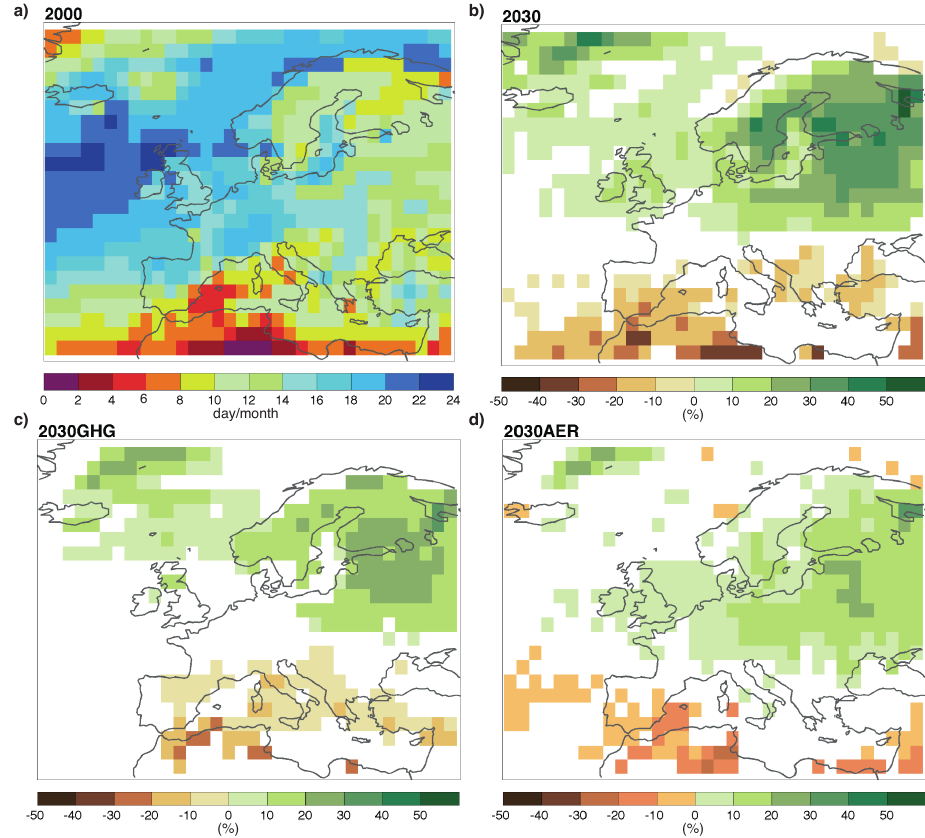
Figure C1. Average number of rainy days per month during winter (DJF) in the 2000 simulation (a) . Percentage changes in the average Fig. C1: Average number of rainy day per month during winter (DJF) in the 2000 simulation (a). 923 number of rainy days per month for 2030 (b) , 2030GHG (c) , and 2030AER (d) simulations during winter. Only differences significant at the Percent changes in the average number of rainy days per month for 2030 (b), 2030GHG (c), and 924 95% confidence level are 2030AER (d) simulations during winter. Only differences significant at the 95% confidence level 925 are shown. 926